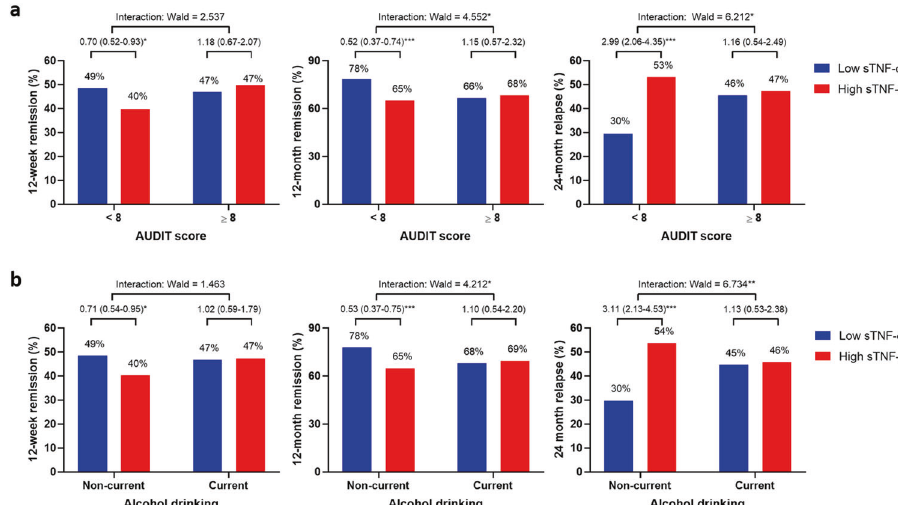
Fig. 2 Effects of the interaction between the serum tumor necrosis factor- α level and alcohol consumption on the incidence of 12-week and 12-month remission and 24-month relapse in patients with depressive disorders. Effects of the interaction between the serum tumor necrosis factor- α (sTNF- α ) level and the Alcohol Use Disorders Identi fi cation Test (AUDIT) score ( a ) or alcohol drinking status ( b ) on the incidence of 12-week and 12-month remission and 24-month relapse in patients with depressive disorders. Data are Wald ’ s scores after adjustment for sex, education, marital status, religious observance status, monthly income, the presence of melancholic features, the presence of atypical features, age at onset, number of depressive episodes, duration of present episode, history of suicide attempts, HADS-A score, and initial antidepressant type. * P < 0.05, ** P < 0.01 and *** P <